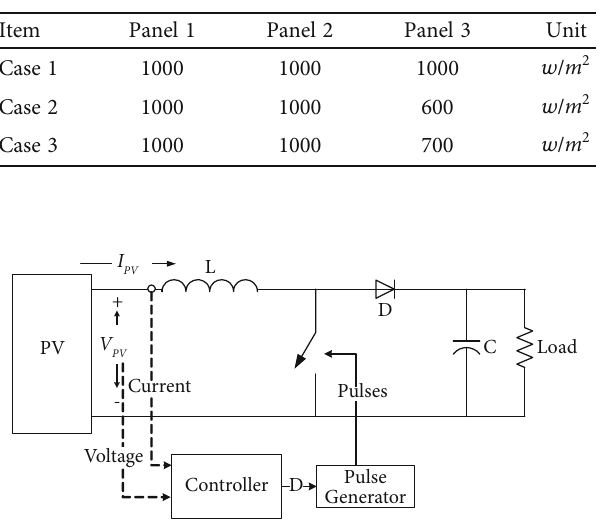
Figure 5: The block diagram of the boost